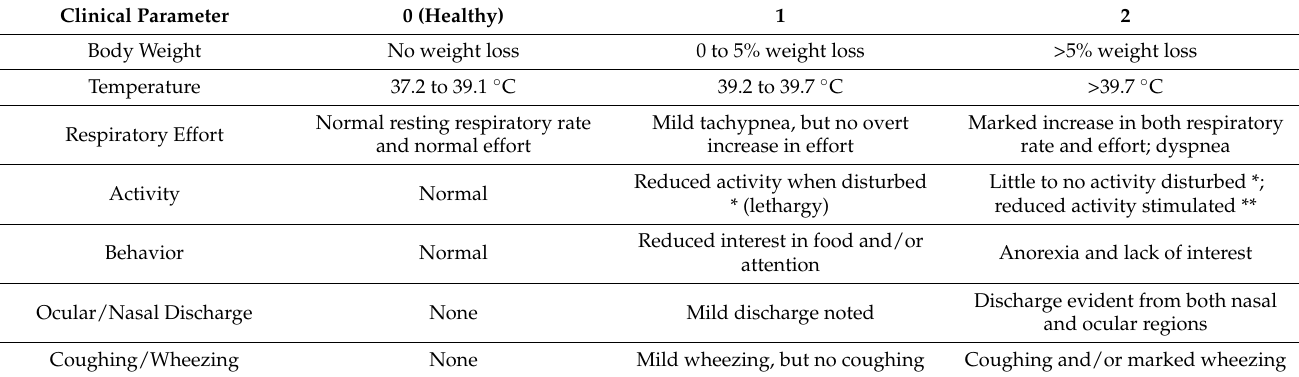
Table 1. Clinical Scoring System for Feline Respiratory Disease. A scoring system was designed to assess clinical lower respiratory and systemic disease in the feline model. Each cat was scored daily at the same time point (morning) by a small animal clinician (JMR). Cats were assigned a score from 0 to 2 for each clinical parameter: body weight, temperature, respiratory effort, activity, behavior, ocular/nasal discharge, coughing/wheezing. The parameter scores were summed to assign an overall score per cat per day. Potential scores could range from 0 (healthy with no signs of disease) to 14 on any given day. Resting respiratory rate was considered normal if <36 breaths per minute. Marked increases in rate were >50 breaths per minute at rest. Temperatures were obtained via thermal microchips. Body weights were obtained last to limit stress affecting clinical